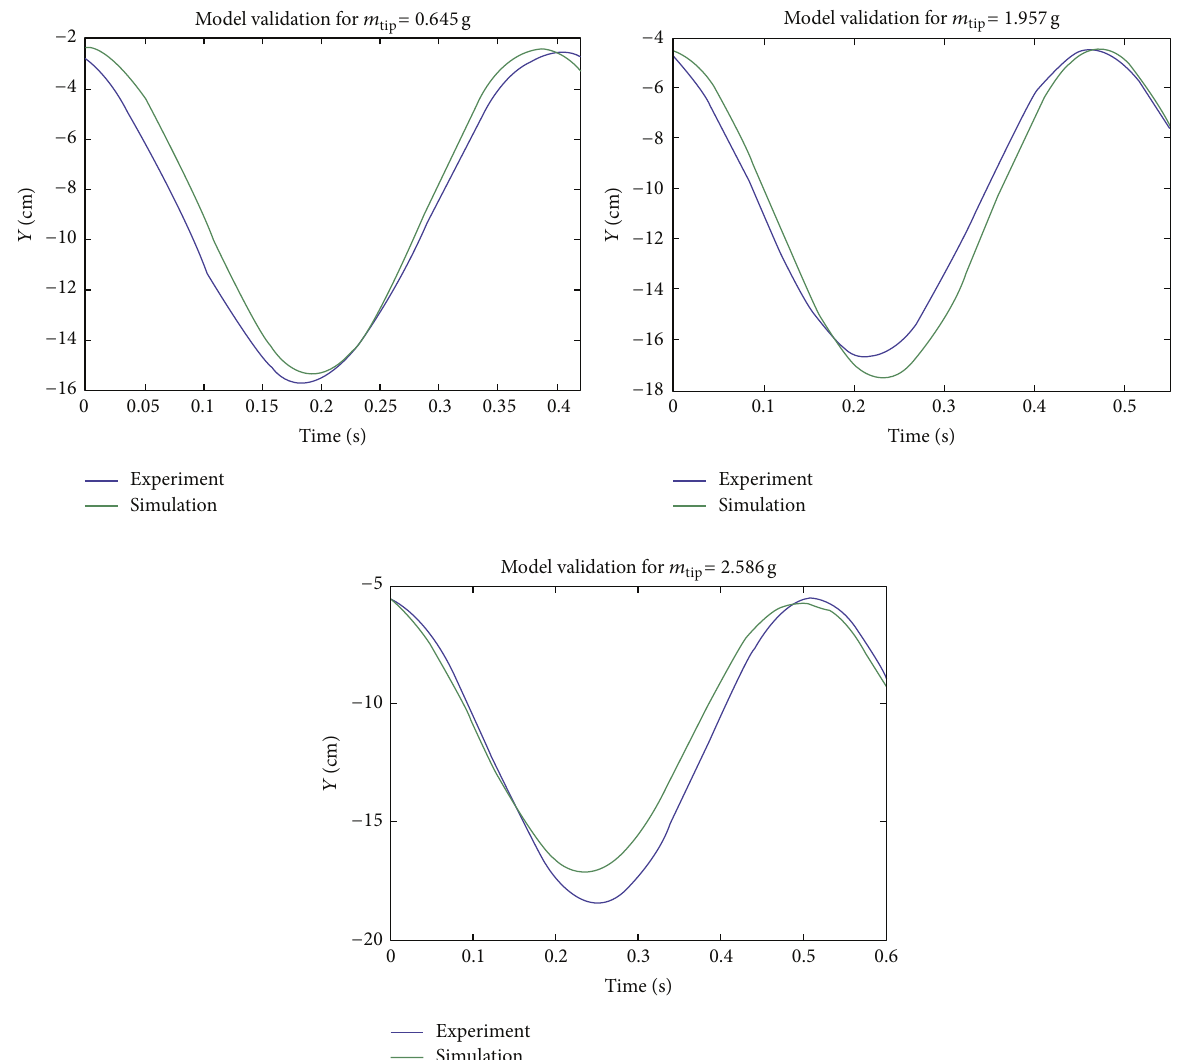
Figure 11: The trajectory of backbone vertical tip position with four different tip